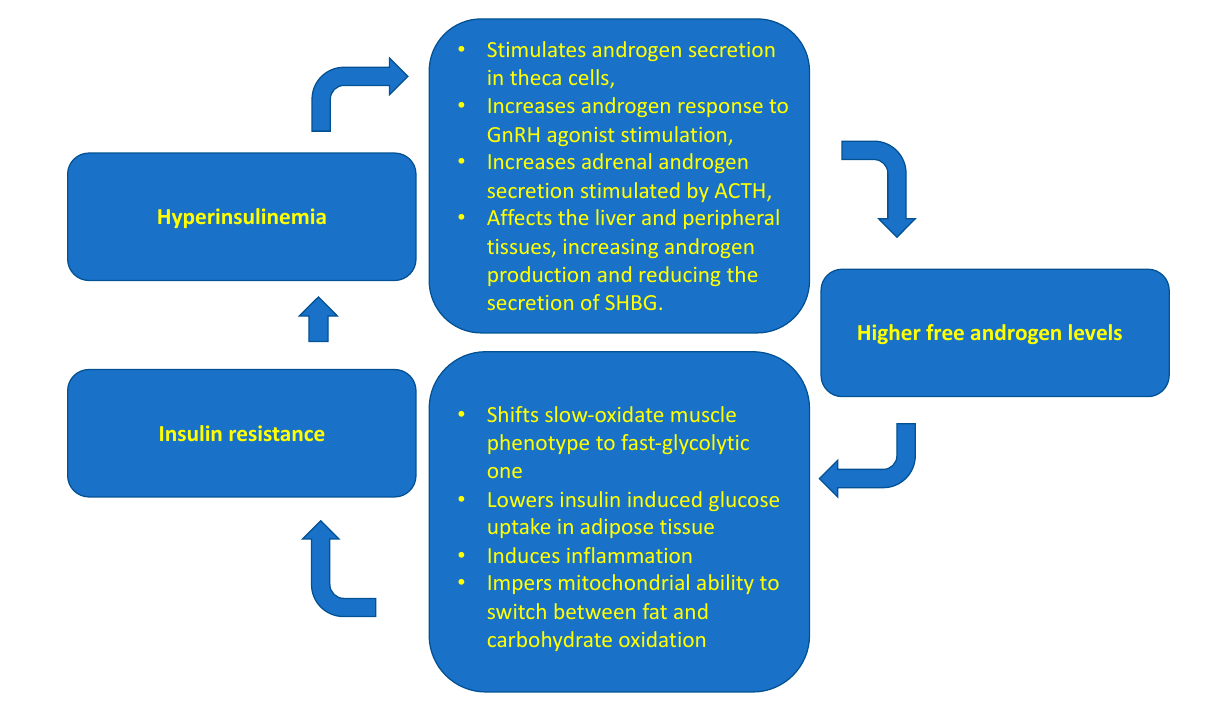
Figure 4. Possible relationships between polycystic ovary syndrome and insulin resistance. The main conclusion is that insulin resistance, the resulting hyperinsulinemia, and increased androgen levels influence each other, and it is difficult to determine which phenomenon occurs first.